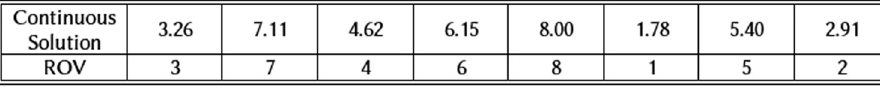
Figure 6: An example of employing ROV on a continuous solution.